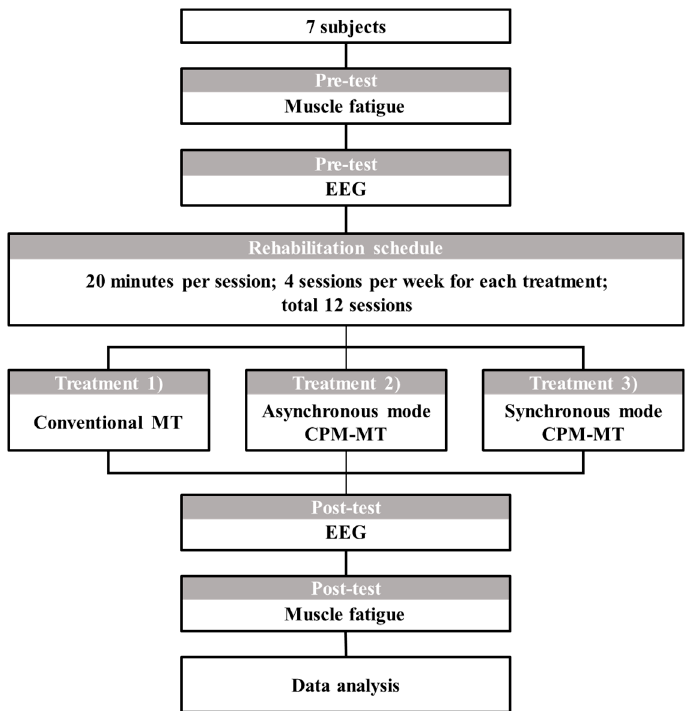
Figure 2. The continuous passive motion mirror therapy (CPM − MT) system overview.